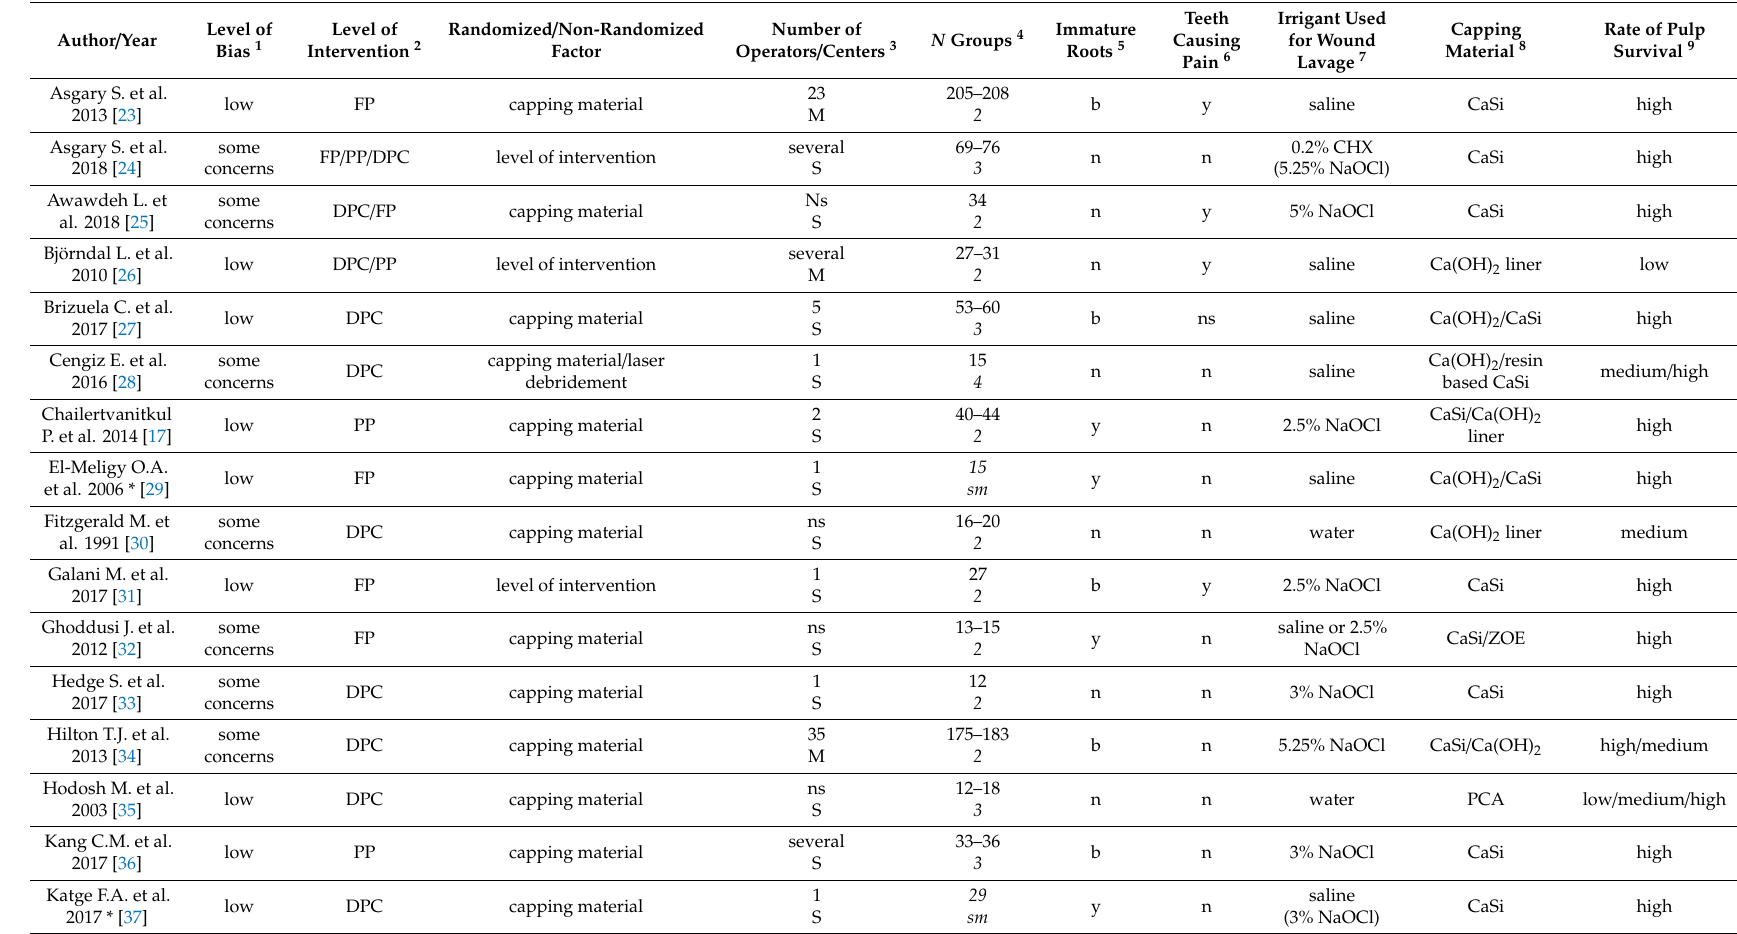
Table 1. Summary of the included